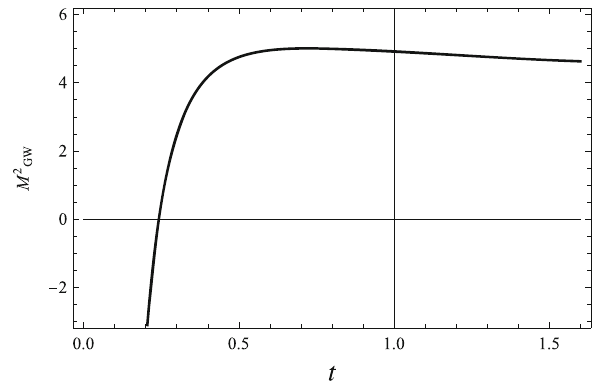
Fig. 5 The behavior of the mass of gravitational wave versus the time t for the values of h 0 = 1 and V 0 = 0 .